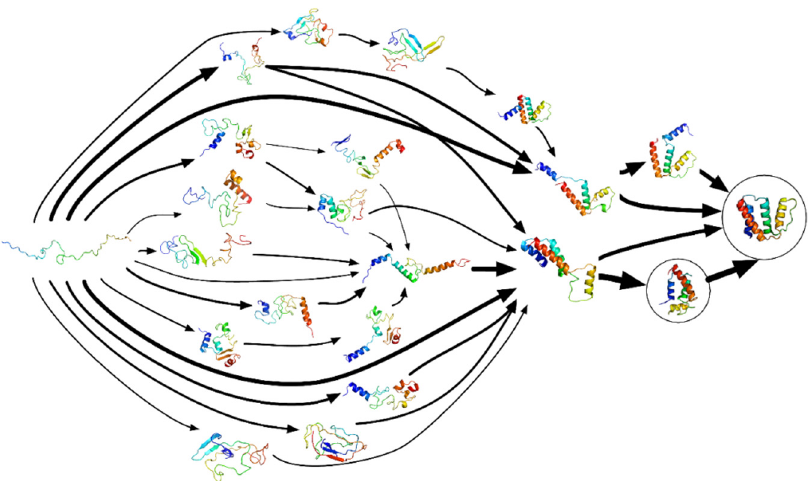
Figure 7. Model of a protein’s possible shapes and folding pathways from its initial randomly coiled state ( left ) into its native 3D structure ( right ) [70].